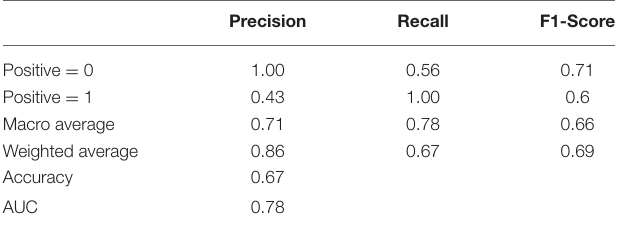
TABLE 6 | Summary of classification performance of the new RF model in classifying patients with or without positive RT-PCR tests.